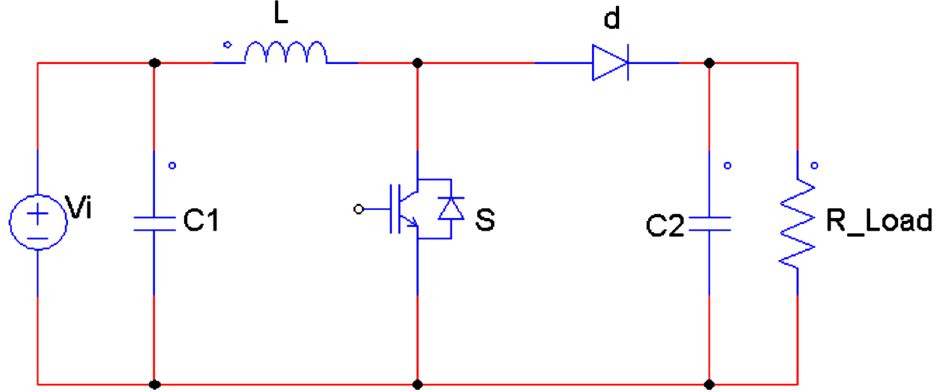
Figure 3. DC/DC boost converter circuit diagram.